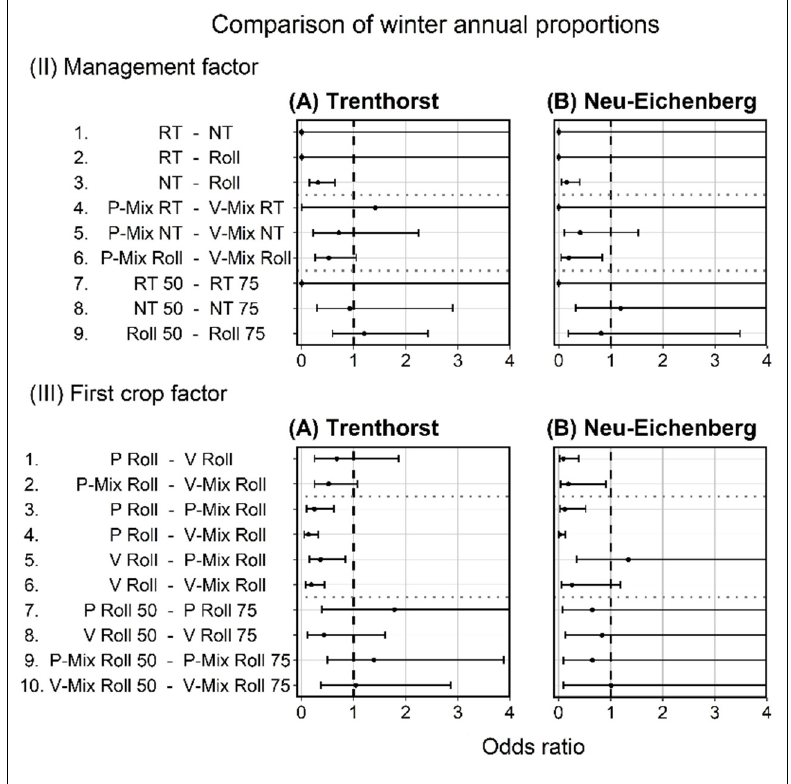
Figure 5. Comparison of winter annuals averaged over year at the two locations with the foci: ( II ) Management factor, ( III ) First crop factor. The contrast in question is shown on the y-axis, whereas its scale is on the x-axis. Factor levels for first crop are: P = winter pea, V = hairy vetch, P-Mix and V-Mix = their mixtures with a cereal partner; for management are: SCS = control, RT = reduced tillage, NT = no tillage, Roll = rolling of first crop; and for row width are: 75 cm and 50 cm. Points represent odds ratios for treatment comparisons. The odds ratios were computed using exponential transformation of the linear contrasts of mean estimates on the logit-scale (log-odds scale). The vertical dashed lines at 1 show the H 0 , where the odds ratio of the estimates is 1 (estimated means are equal). Error bars show the 95% CI of the estimated difference after multivariate t adjustment. Thus, when this crosses the vertical dashed line (H 0 ), there is statistically no or non-significant difference between means at α = 0.05. Each focus group is analyzed independently. Please note that for treatments with only zero observations, the model estimates the full possible range (0–1) as CI. Additionally, DCS NT treatments at TRE were only present in the second